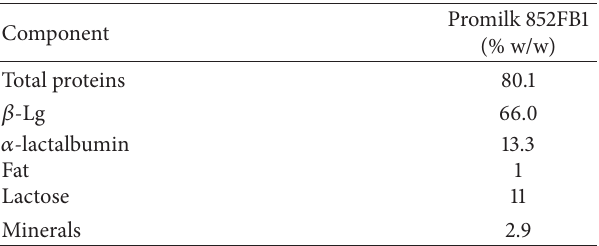
Table 1: Composition of WPI